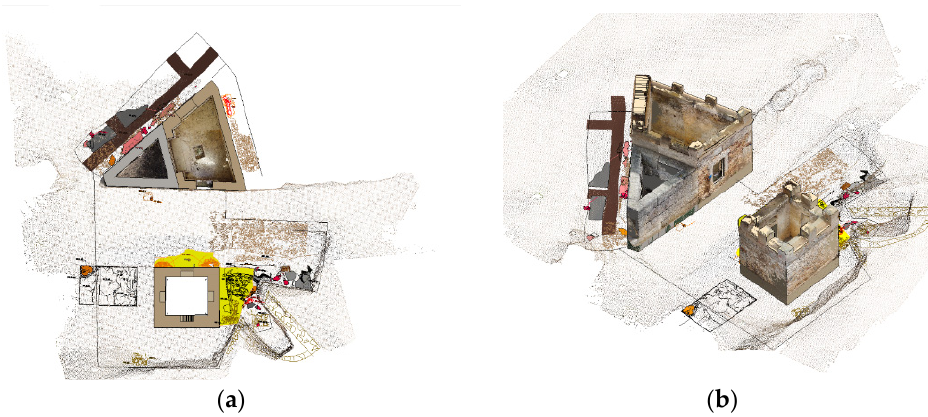
Figure 22. Plans with the documentation extracted from ancient archaeological excavations. ( a ) Top view of the archaeological documentation introduced in the model. ( b ) Perspective view of the archaeological documentation introduced in the model.